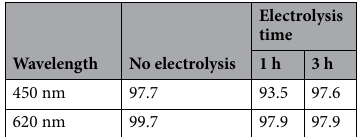
Table 5. Transparency of the Gel electrolyte.